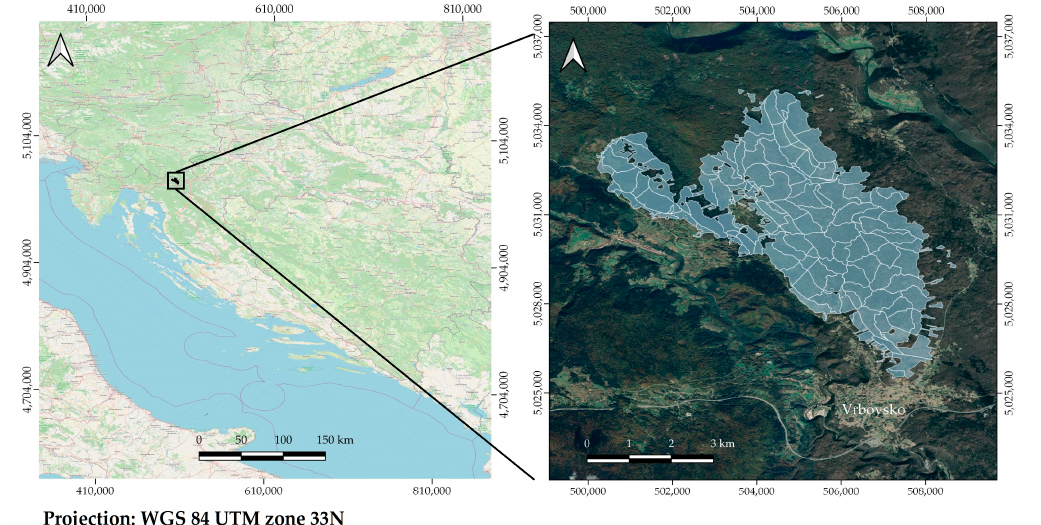
Figure 1. The location of the study area, forest management unit (FMU)